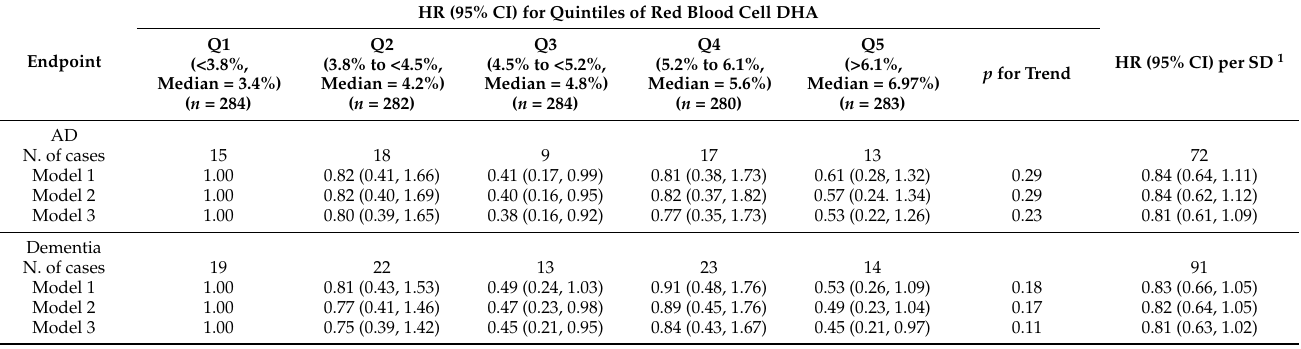
Table 3. Hazard ratios (HR) for red blood cell DHA on Alzheimer’s disease (AD) and all-cause dementia ( n = 1453) ignoring 37 individuals with incident Alzheimer’s or all-cause dementia within five years of baseline.